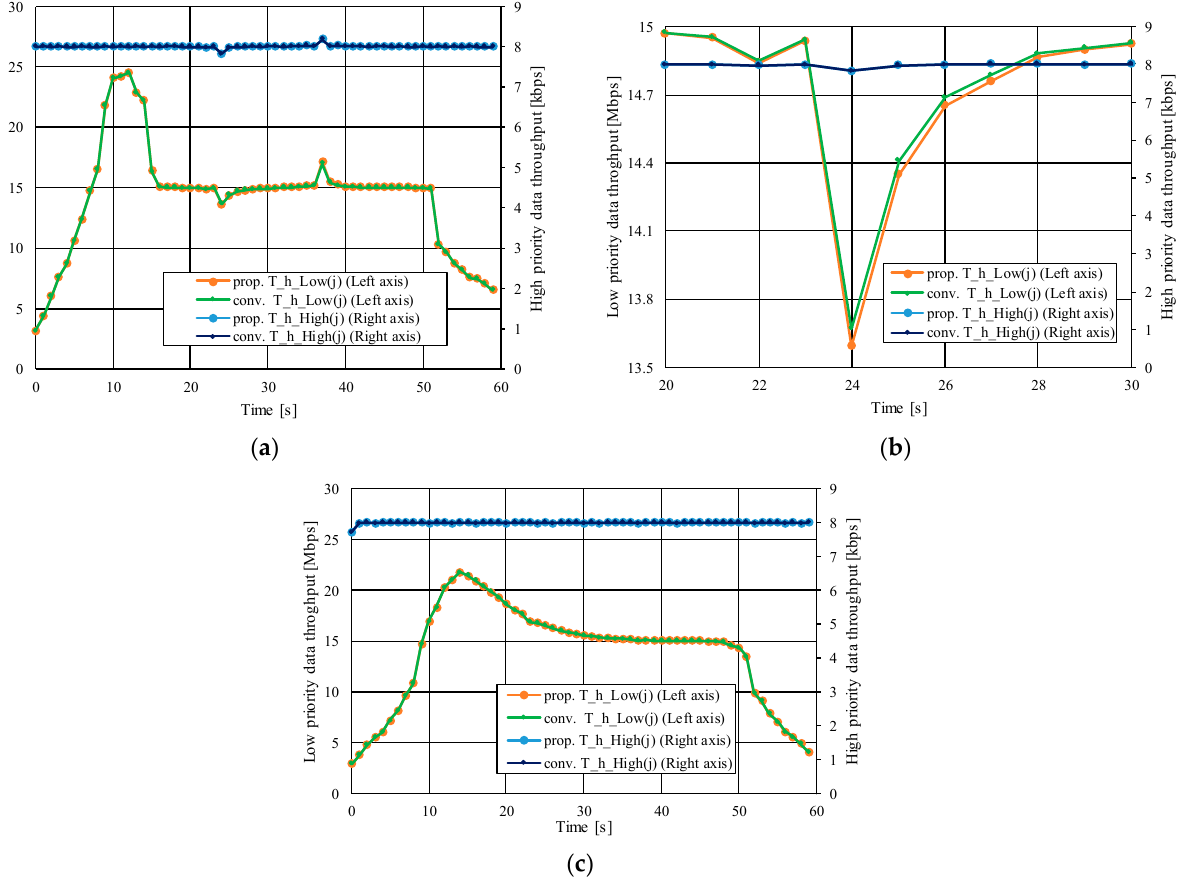
Figure 13. Throughput characteristics; ( a ) Scenario C, ( b ) enlarged view of Scenario C, ( c ) Scenario D.